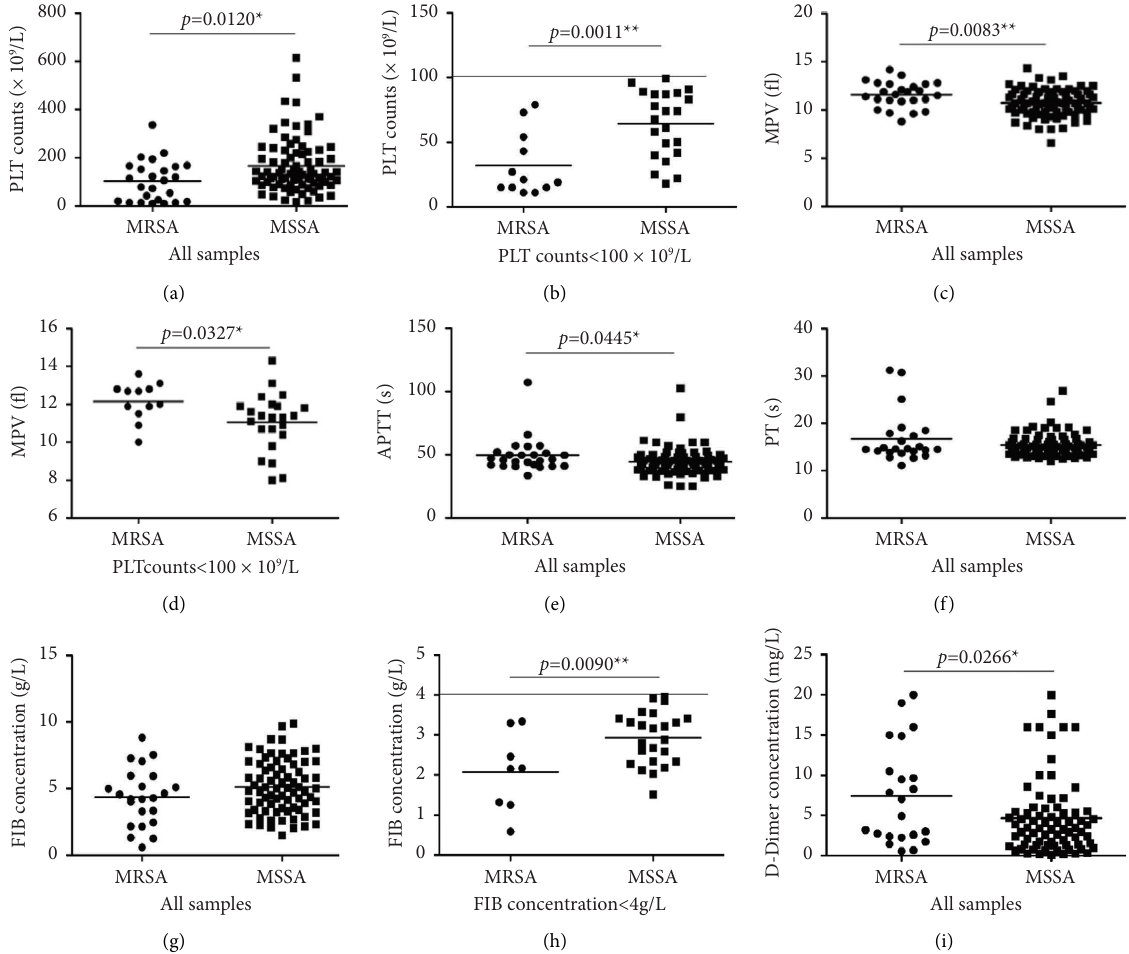
Figure 4: Comparison of peripheral blood coagulation indexes of patients infected with MRSA or MSSA. (a) PLT counts (all samples). (b) PLT counts (thrombocytopenia patient). (c) MPV (all samples). (d) MPV (thrombocytopenia patient). (e) APTT. (f) PT. (g) FIB concentration (all samples). (h) FIB concentration (fbrinogenopenia patient). (i) D-dimer